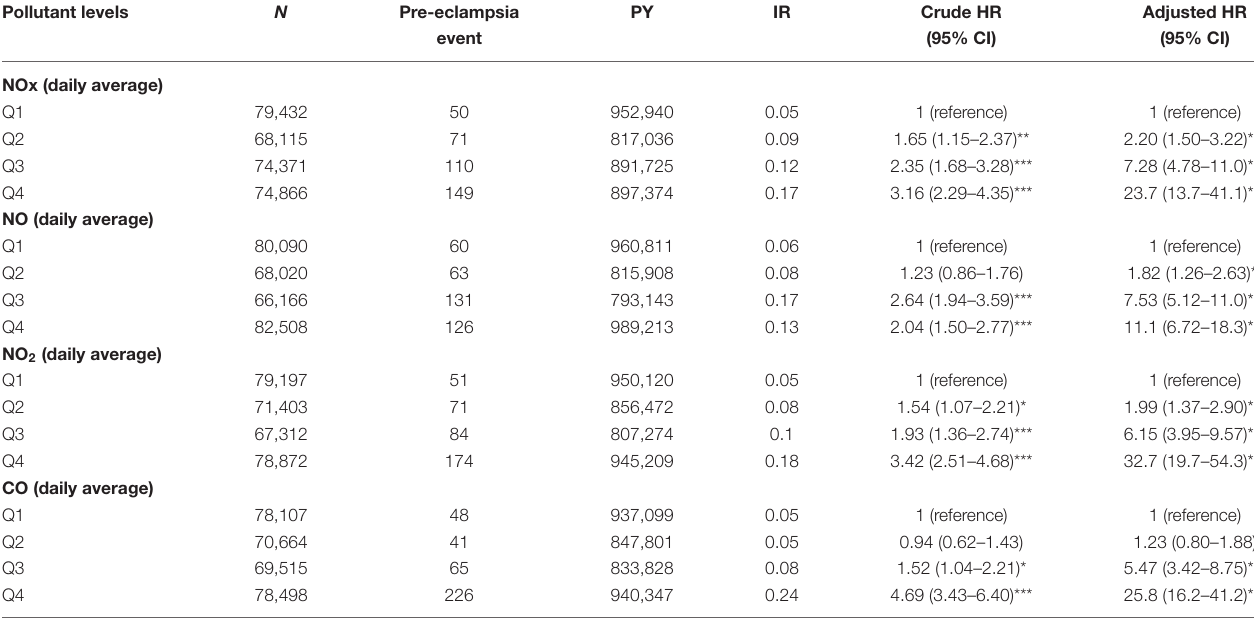
TABLE 3 | Difference in pre-eclampsia and eclampsia incidences and associated HRs in participant exposed to various daily average concentration of air pollutants. Pollutant levels N Pre-eclampsia PY IR Crude HR Adjusted HR event (95% CI)